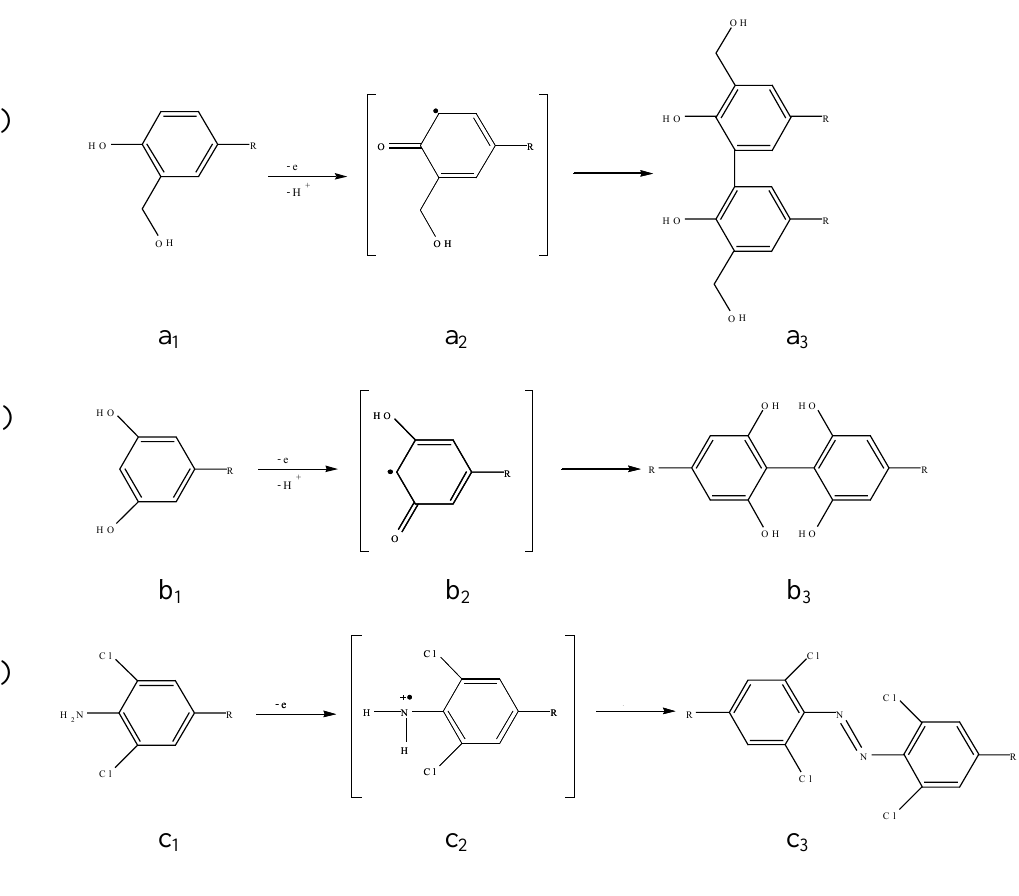
, b and c ), intermediate (a 1 1 1